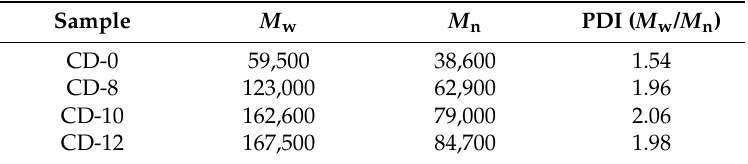
11 of 20 Table 1. Molecular weight determination. Sample